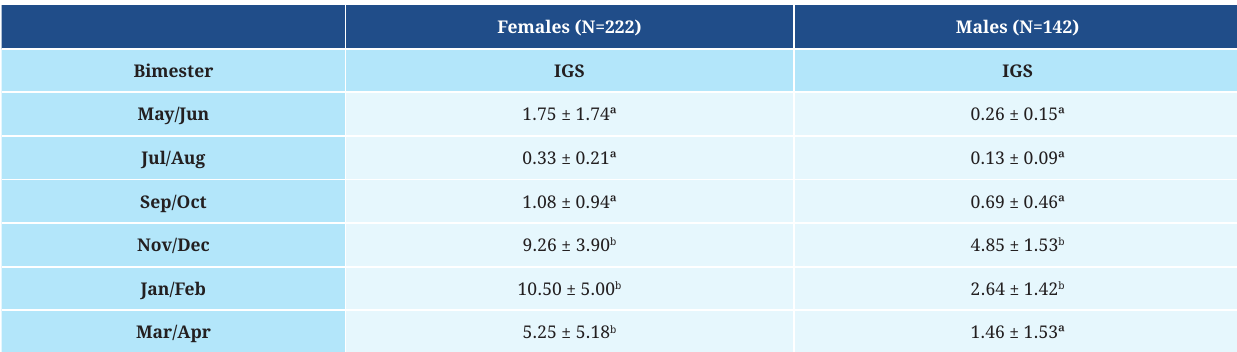
TABLE 3 | Average gonadosomatic index (GSI) values each bimester of Leporinus piau females and males captured in the Três Marias Reservoir (TMR) of the São Francisco River basin (SFR) from May 2015 to April 2016.